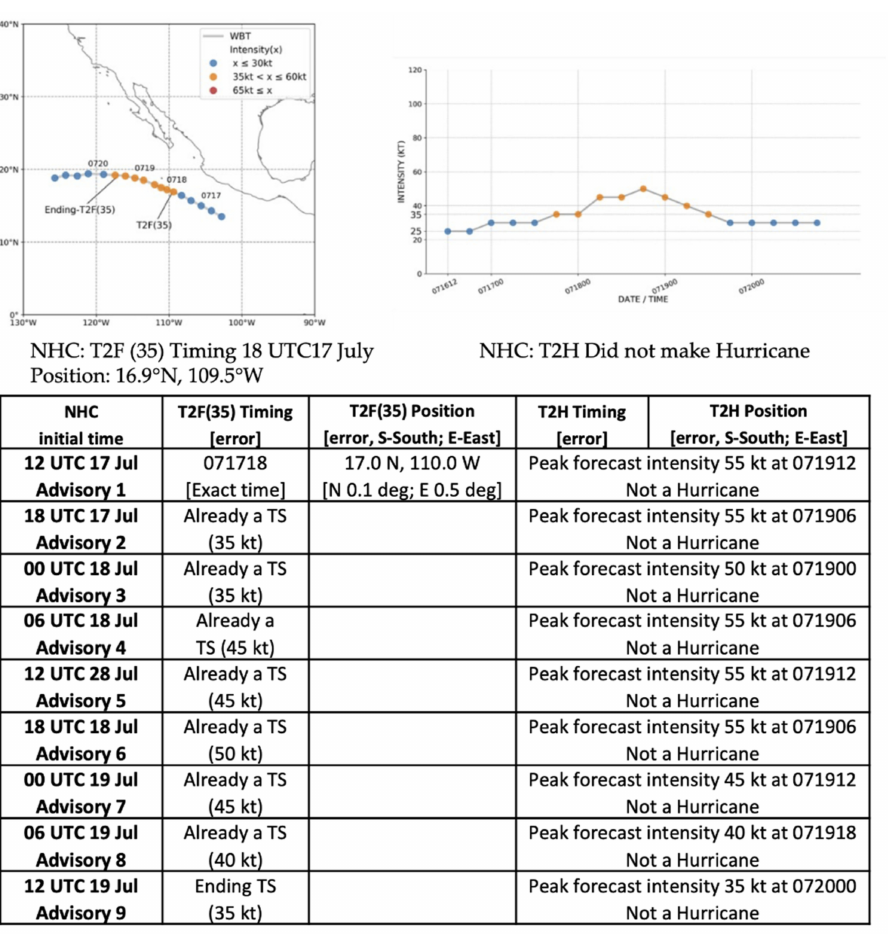
Figure 18. National Hurricane Center (NHC) forecasts of the T2F(35) and the forecast peak intensity timing and positions based on NHC advisories as in Figure 4 except for